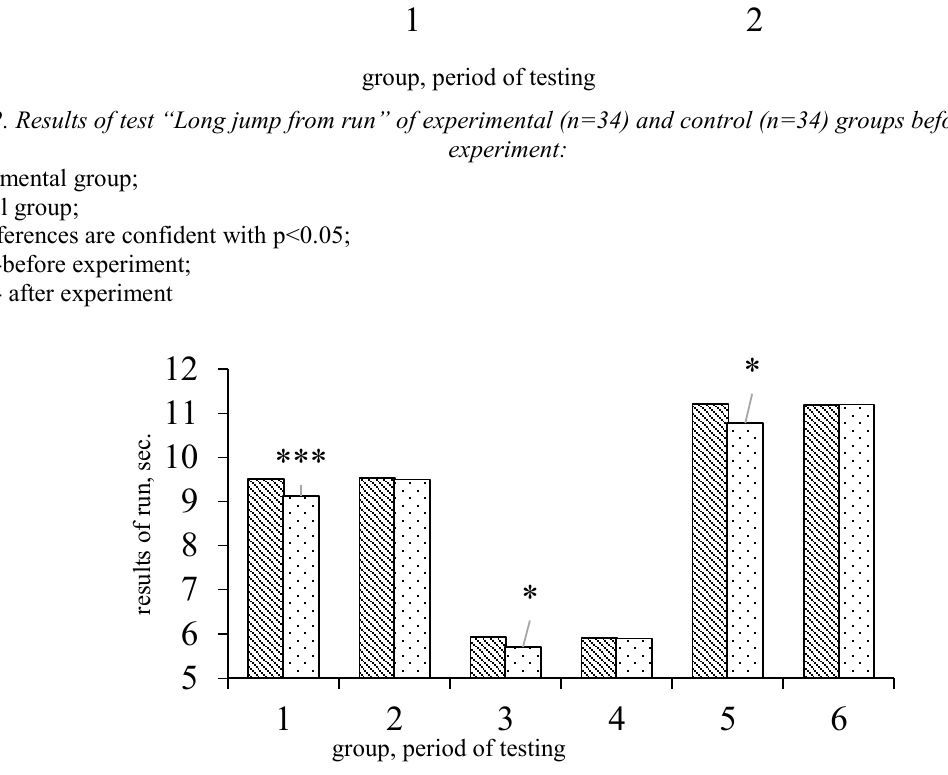
Fig. 3. Results of run tests of experimental (n=33) and control (n=34) groups before and after